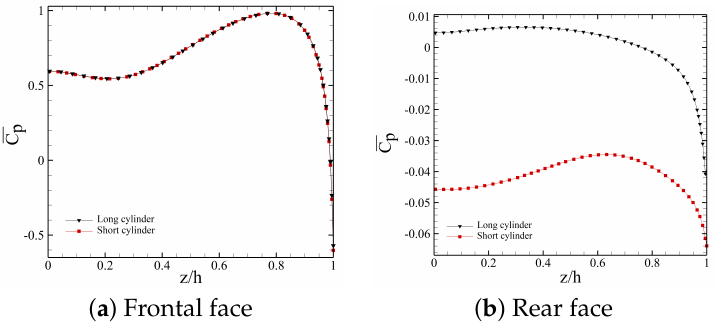
Figure 9. Profiles of surface pressure along the prism height at y / h = 0 for their frontal and rear faces. Focusing on the flow field and main characteristics of the wake, the critical points on different faces of the long rectangular and square prisms are shown in Figures 10 and